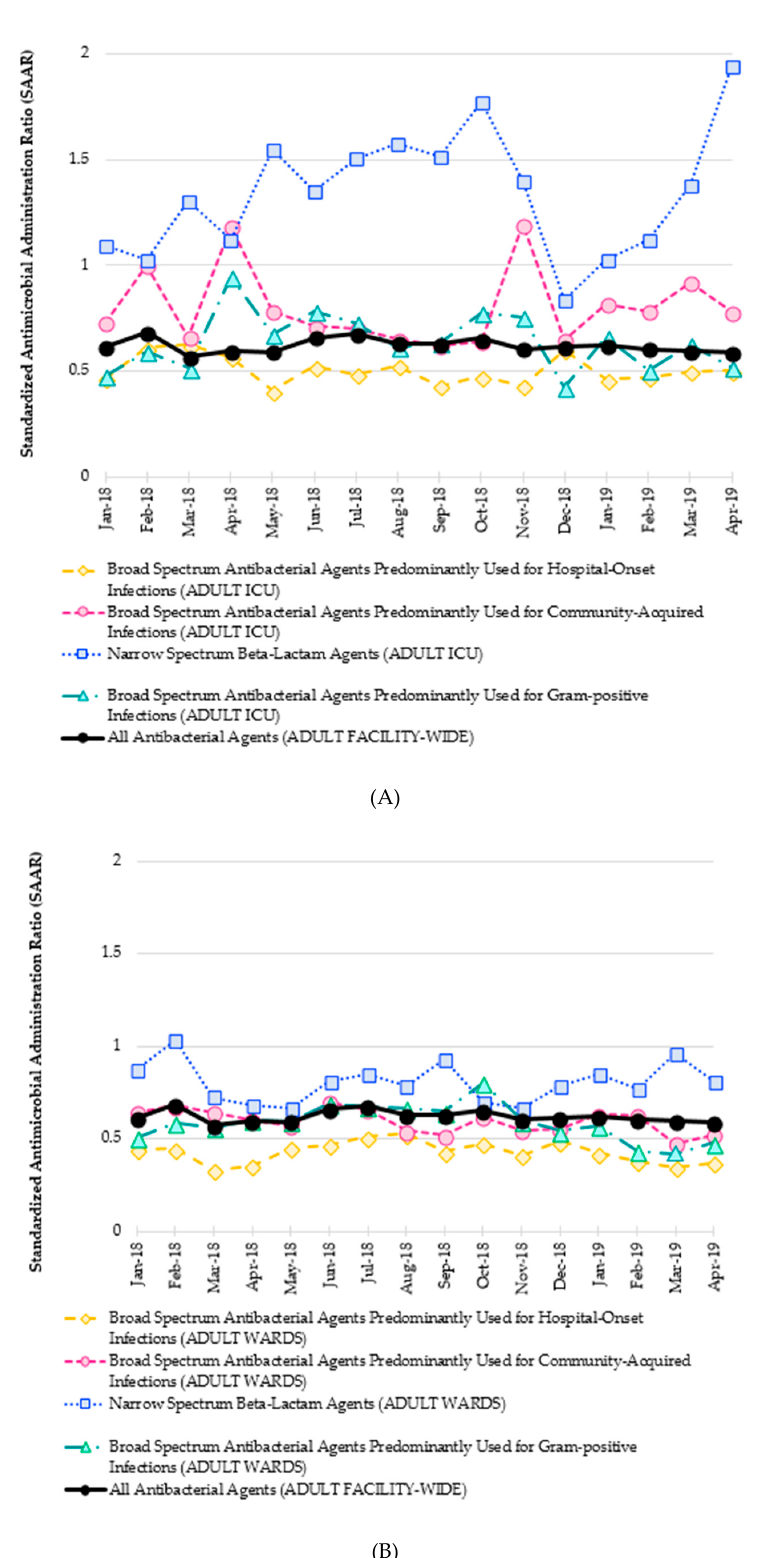
Figure 1. ( A ) Standardized Antimicrobial Administration Ratio (SAAR) report for all and select categories of antibacterial agents in adult intensive care units (ICUs) at a community-teaching hospital. ( B ) Standardized Antimicrobial Administration Ratio (SAAR) report for all and select categories of antibacterial agents at adult wards at a community-teaching hospital.